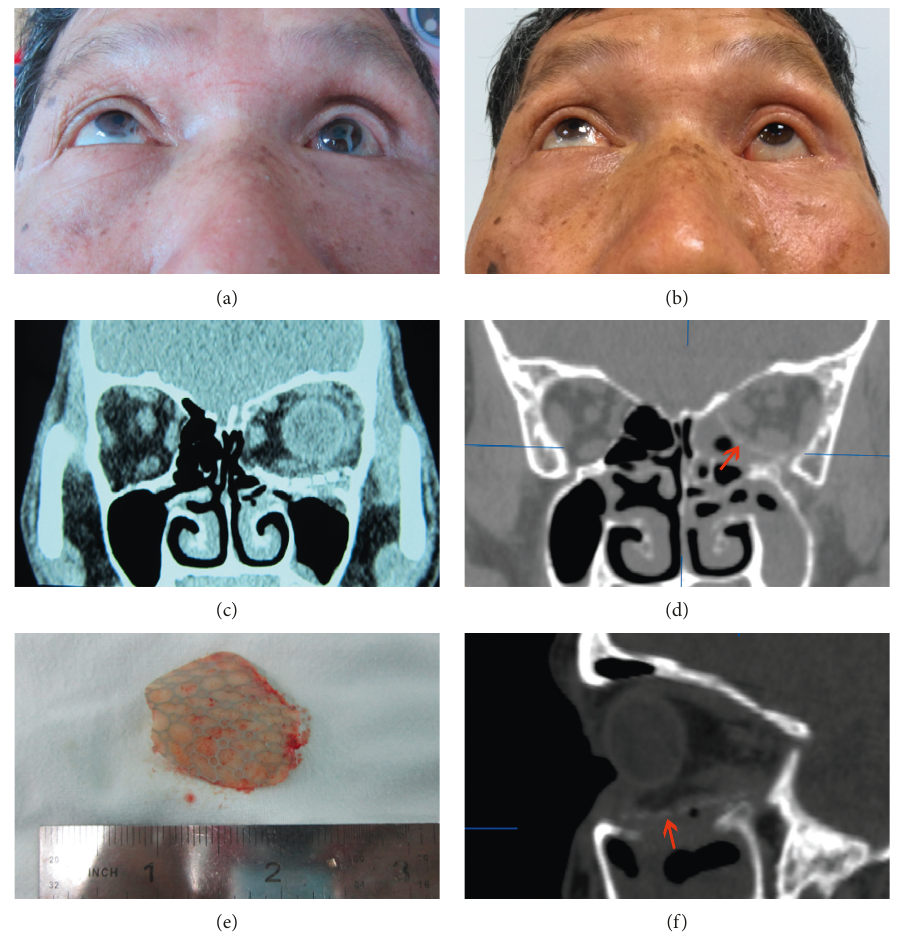
Figure 2: Case of a malpositioned Medpor Titan implant. (a) The left eye exhibited enophthalmos 5months after primary surgery. (b) The enophthalmos was fully corrected over a 16month follow-up. (c) The implant reconstructed only the wall of the orbital floor leaving the medial wall unrepaired. (e) The explanted Medpor Titan mesh. (d and f) A CTscan shows the newly positioned implant totally covering the orbital medial wall and floor defects (red